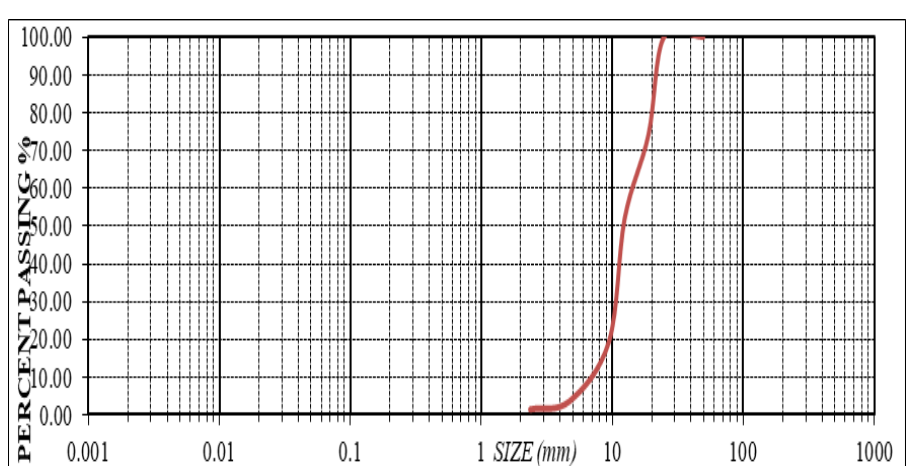
Fig. 2. Report of the pea sand aggregation